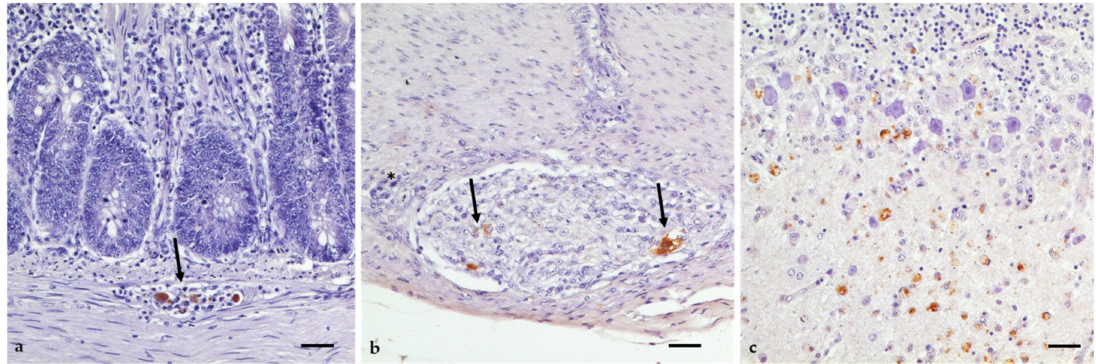
Figure 9. Immunohistochemical detection of WNV antigens in geese. ( a ) Plexus submucosus in the gut of G 1 (6 dpi) with viral antigen (arrow). ( b ) Plexus myentericus in the gut of G 11 (7 dpi). Viral antigens are distinctly seen in neurons and glial cells (arrows). Additionally, slight lymphohistio- cytic infiltration can be seen (star). ( c ) Cerebellum/molecular layer of G 11 with a foci of altered neurons and glial cells accumulating viral antigens. Immunohistochemistry, pab (in-house) OM8; bars = 20 µ